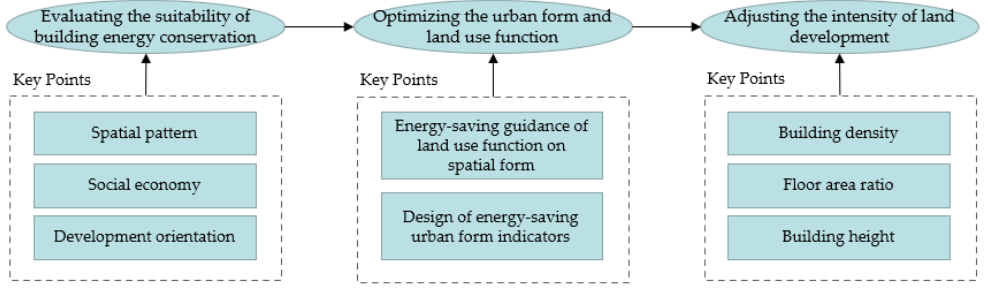
Figure 14. Guiding measures for energy-saving-oriented urban form planning.